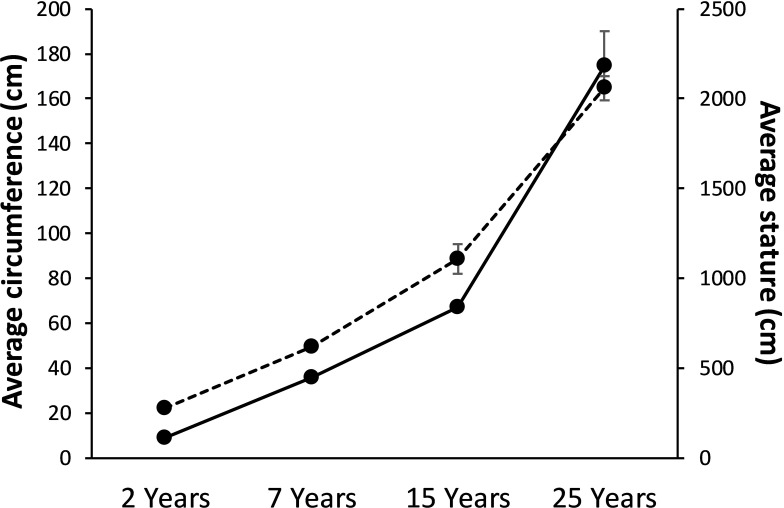
Average circumference (solid line) and stature (dash line) of Dipterocarpus alatus at different ages.Data are shown as mean±SD.